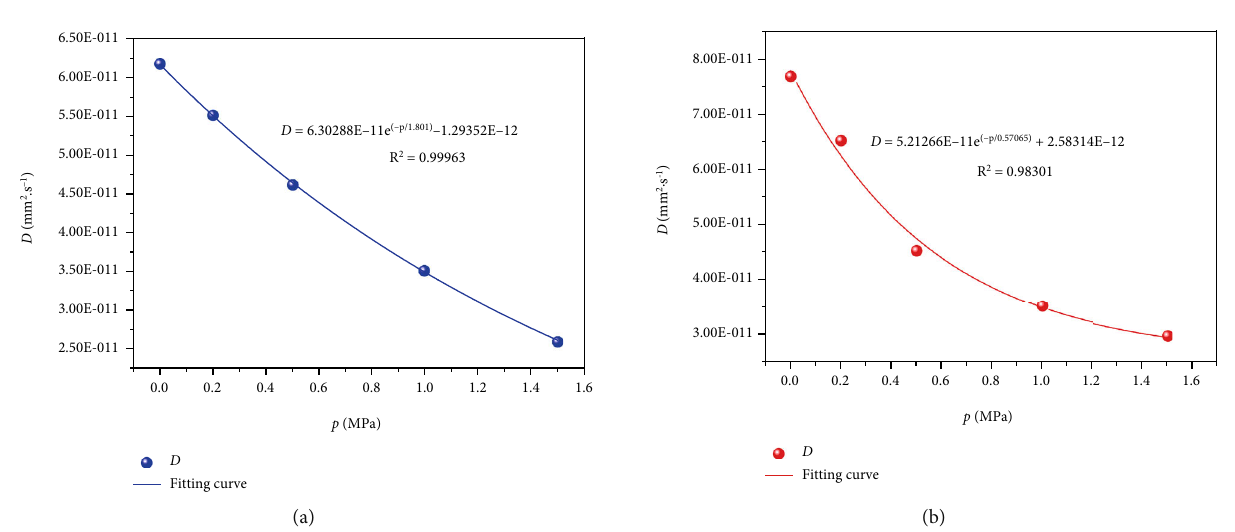
Figure 8: The fi tting of the positive pressure and di ff usion coe ffi cient data: (a) Sihe sample and (b) Canghai sample. Table 6: Numerical solution